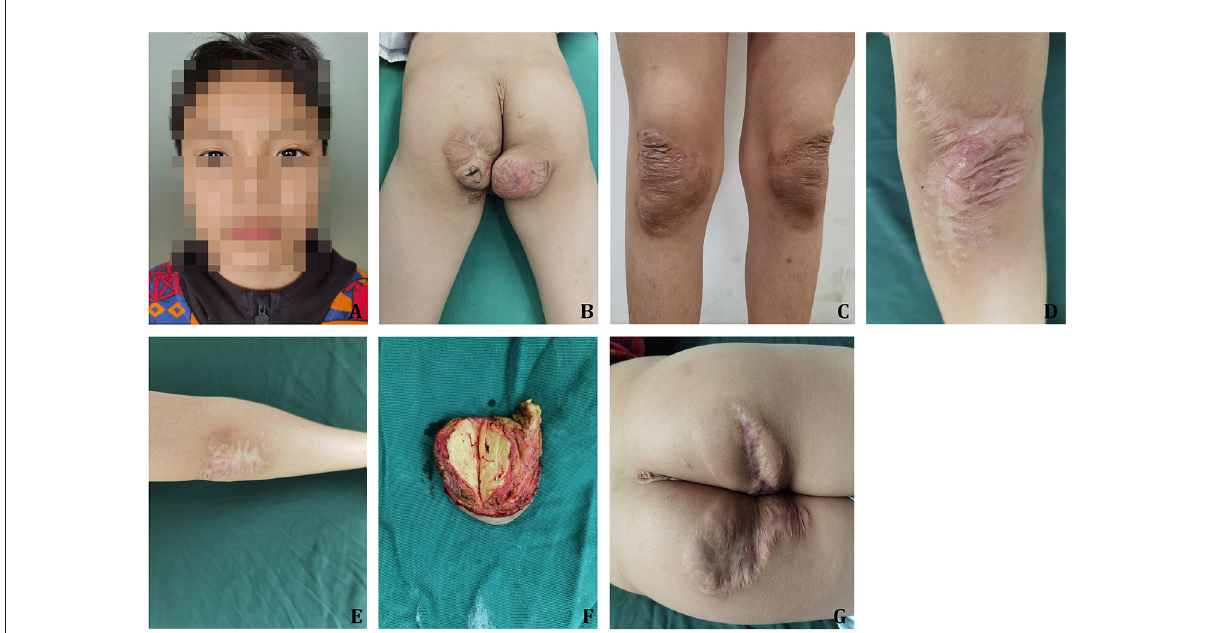
FIGURE1 Case 1. (A) Xanthelasmas of the bilateral eyelids. (B) Xanthoma at the buttocks. (C) Partial shrinkage of tumor in the bilateral knee joints after lipid-lowering therapy. (D) One year after resection of xanthoma at the left elbow. (E) One year after resection of xanthoma at the right elbow.